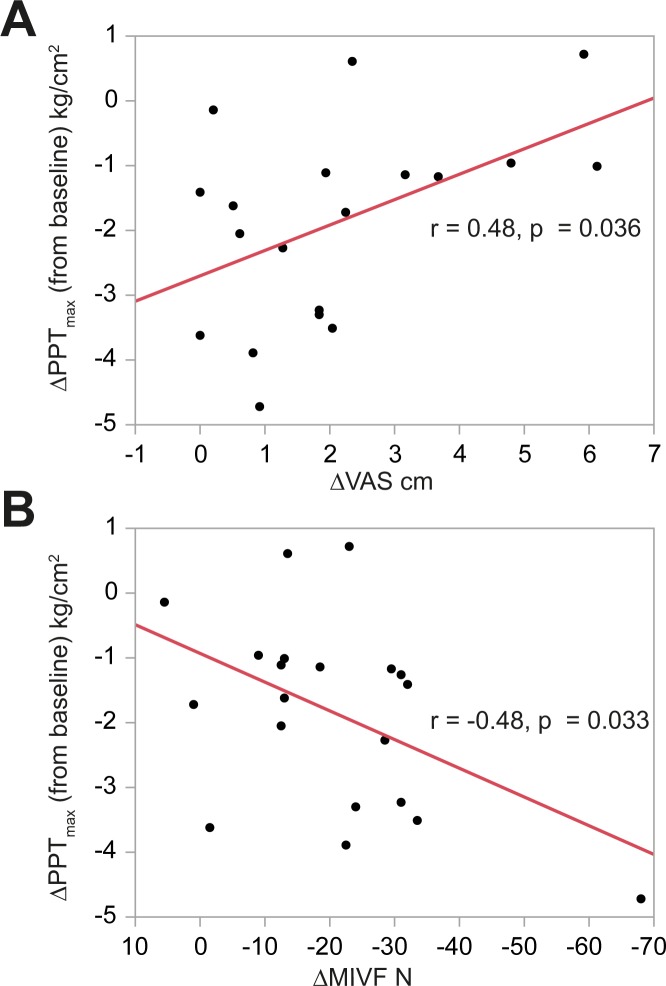
Displays the correlation between the change in PPT (in kg/cm2, with negative numbers indicating an increase in pressure pain) and the change in maximum pain intensity (in cm VAS, A) or MIVF (in N, B).